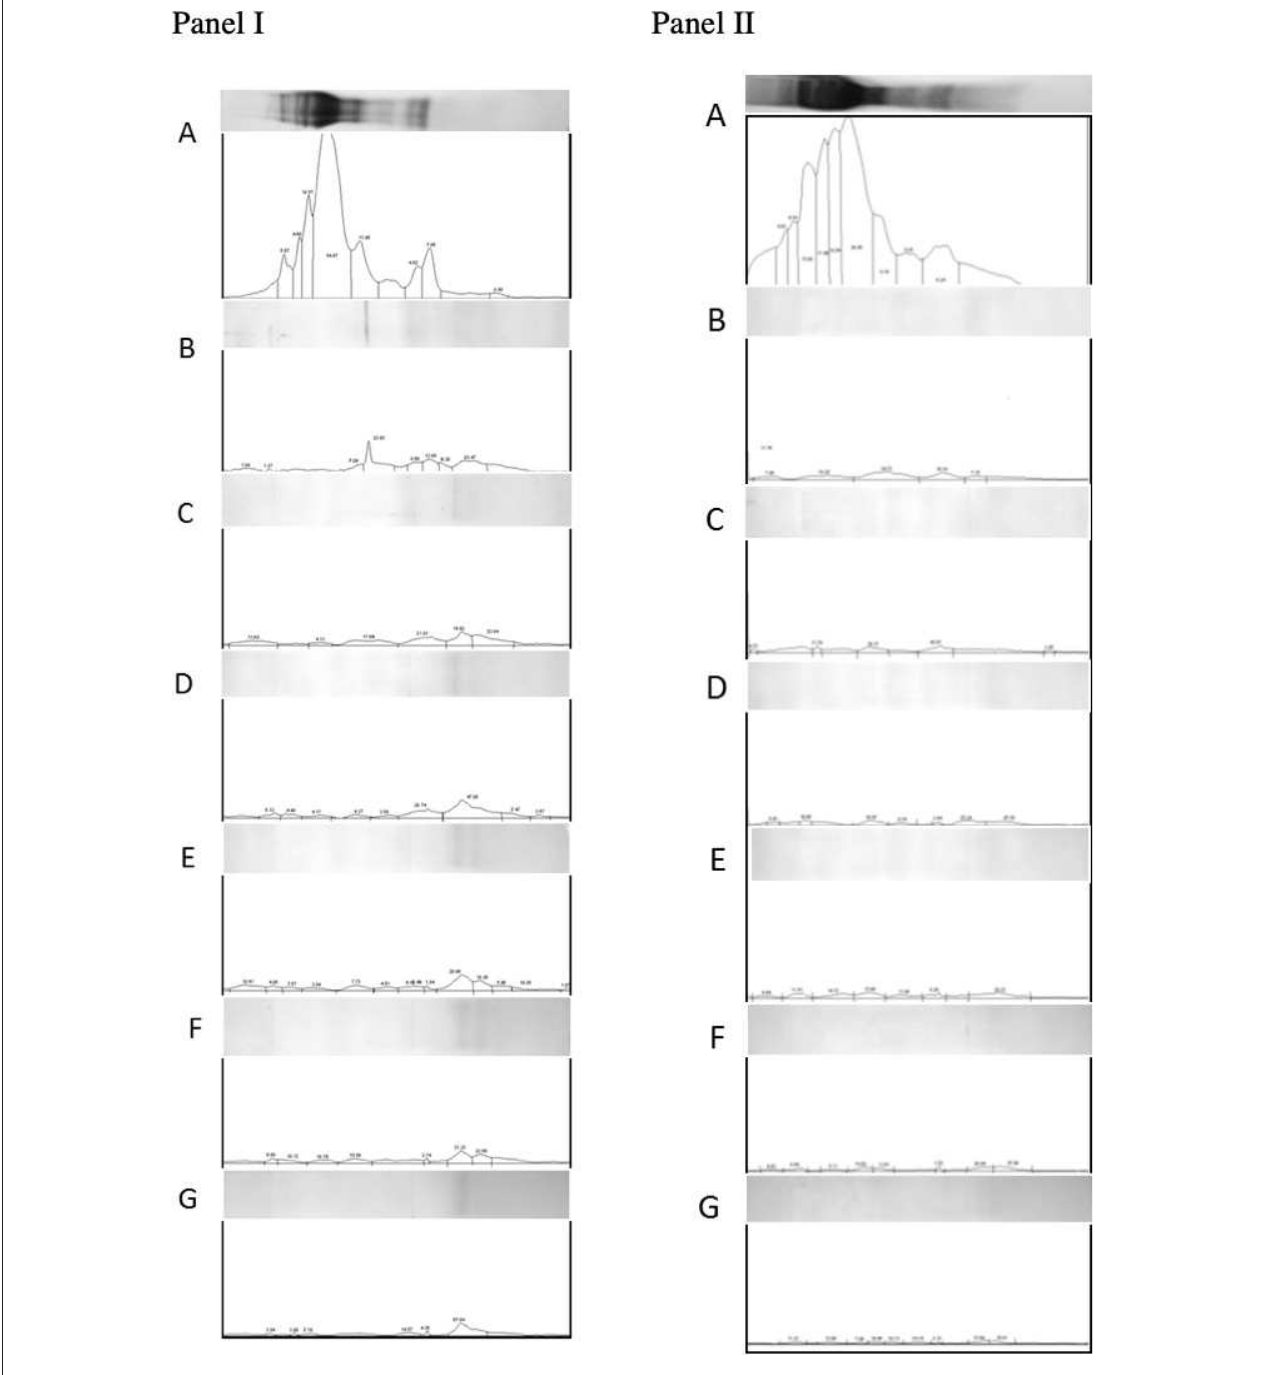
FIGURE 5 | Densitometric analysis of gliadin (panel I) and glutenin (panel II) fractions loaded on Tricine-PAGE. (A) Undigested gliadins/glutenins (negative control). (B) Gliadins/glutenins digested with gastric and pancreatic enzymes. (C) Gliadin/glutenin fraction digested with gastric-pancreatic enzymes in combination with barley cysteine endoprotease B2 (EP-B2). (D) Gliadin/glutenin fraction digested with gastric-pancreatic enzymes, EP-B2, and native Flavobacterium meningosepticum prolyl endopeptidase (Fm-PEP) (positive control). (E) Gliadin/glutenin fraction digested with gastric-pancreatic enzymes, EP-B2, and Fm-PEP variant, Fme5. (F) Gliadin/glutenin fraction digested with gastric-pancreatic enzymes, EP-B2, and Fm-PEP variant, Fme6. (G) Gliadin/glutenin fraction digested with gastric-pancreatic enzymes, EP-B2, and Fm-PEP variant, Fme10.